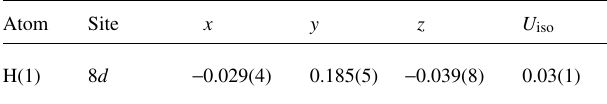
Table 2. Atomic coordinates and displacement parameters (in Å 2 )